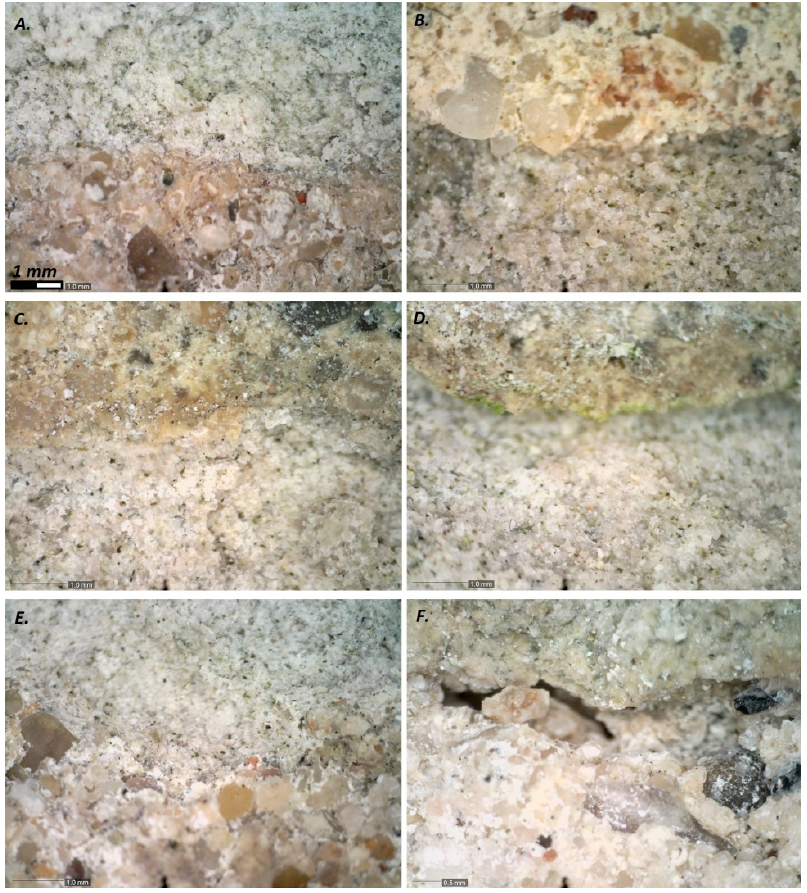
Figure 11. USB micrographs showing: ( A ) well bonded putty mortar (WRD12); ( B ) poorly bonded putty mortar (WRD27); ( C ) well bonded NHL mortar (WRD29); ( D ) poorly bonded NHL mortar with algal growth (WRD30); ( E ) well bonded old mortar (WRD53); ( F ) and poorly bonded old mortar (WRD39). (scale bar 1mm).